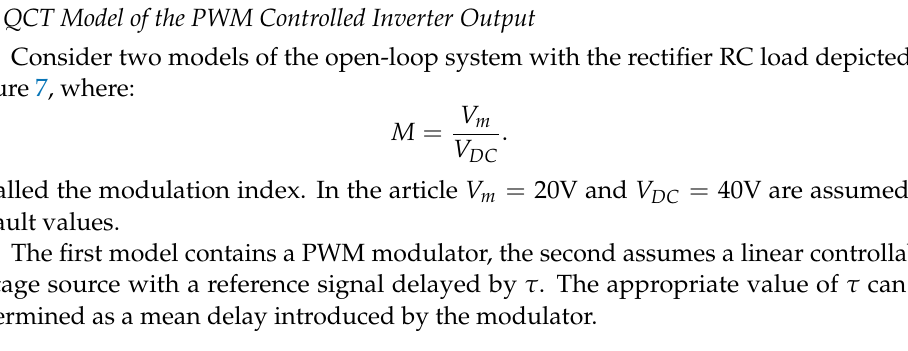
Figure 6. Illustration of various modulation methods: ( a )-PAM, ( b )-PWM S , ( c )-PWM Λ , ( d )-PWM V . Red crosses denote samples of the input signal, yellow dots-switching instants on the intersection of the modulating function with appropriate sampled value.